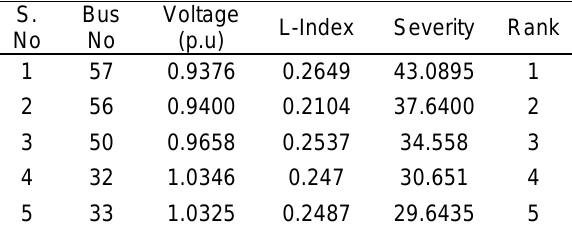
Table 7. Fuzzy severity of weak nodes